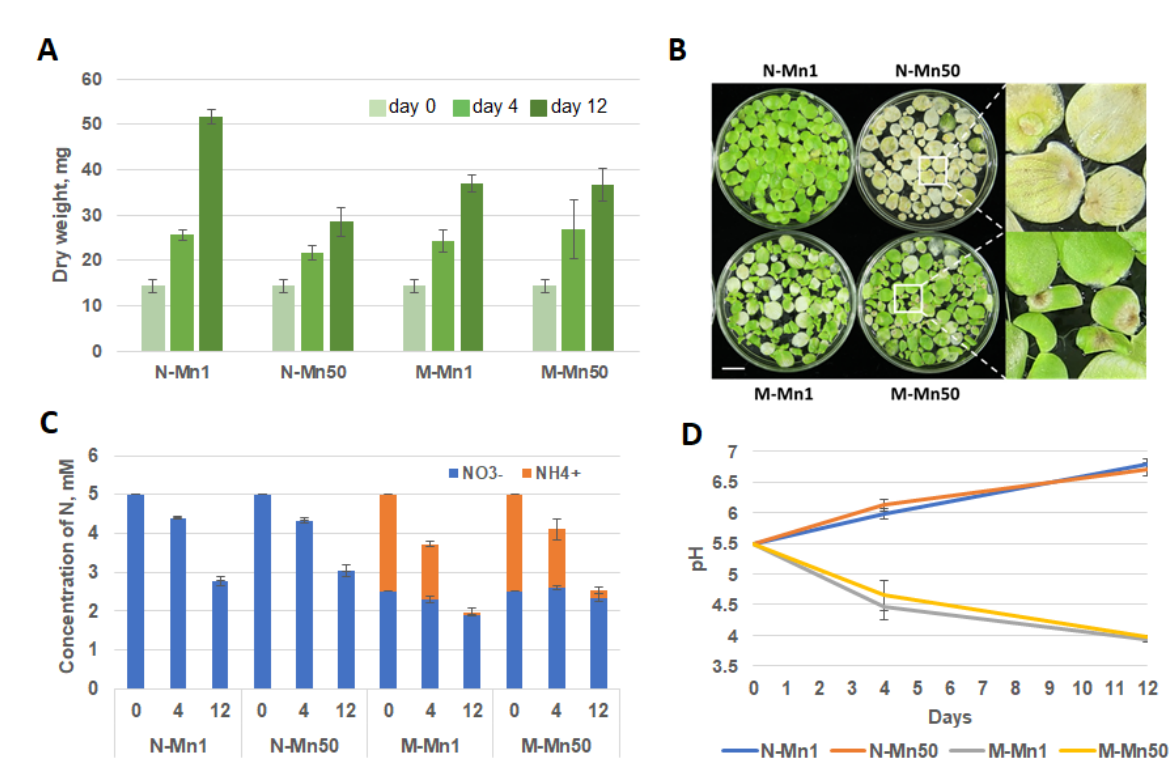
Figure 1. Dynamic parameters related to duckweed cultivation in media with different formulations of N and Mn: ( A ) Duckweed biomass at the beginning of the experiment, (light green) and following 4 days (green) and 12 days (dark green) cultivation in media supplied with different concentrations of nitrate, ammonium and Mn. N-Mn1—medium containing 5 mM NO (cid:2871)(cid:2879) and 0.059 mM Mn; N-Mn50—medium containing 5 mM NO (cid:2871)(cid:2879) and 2.95 mM Mn; M-Mn1—medium containing a mixture of 2.5 mM NO (cid:2871)(cid:2879) , 2.5 mM NH (cid:2872)(cid:2878) and 0.059 mM Mn; M-Mn50—medium containing a mixture of 2.5 mM NO (cid:2871)(cid:2879) , 2.5 mM NH (cid:2872)(cid:2878) and 2.95 mM Mn. ( B ) Images of S. polyrhiza fronds taken at day 12 follow- ing cultivation in media supplied with different concentrations of nitrate, ammonium and Mn; ( C ) Comparative dynamics of nitrogen uptake, supplied in the medium in form of nitrate ( NO (cid:2871)(cid:2879) ) or am- monium ( NH (cid:2872)(cid:2878) ); ( D ) Comparative dynamics of pH of four cultivation media in course of duckweed growth. Bar is 1 cm.